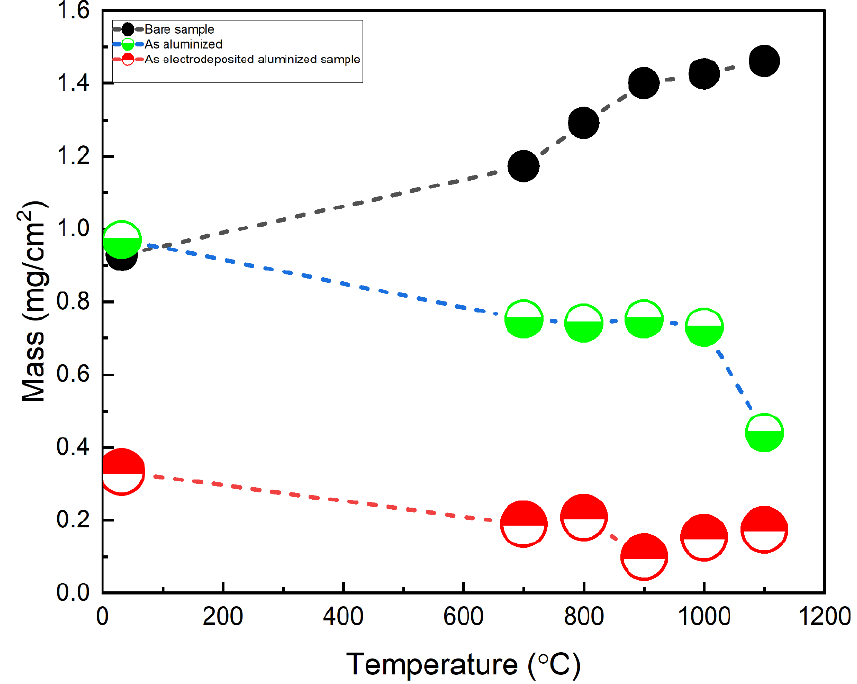
Figure 12. Mass change curves in the temperature range of 700 ◦ C–1100 ◦ C: (i) bare alloy, (ii) as- aluminized, and (iii) electrodeposited-aluminized samples. The environment used is the mixture of Na 2 SO 4 + NaCl (3:1 by